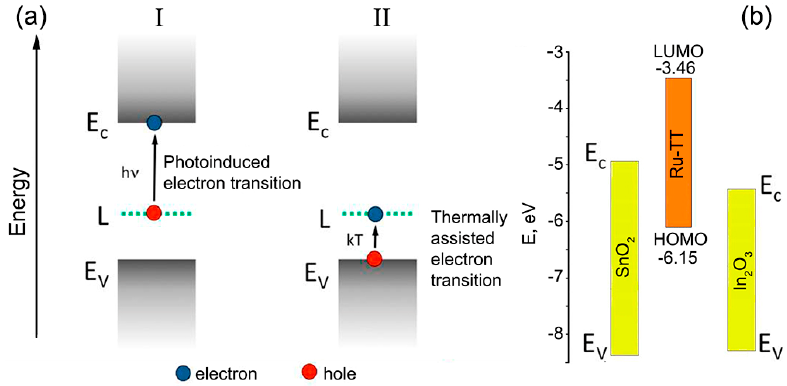
Figure 8. ( a ) Scheme of the consequential mechanism for the generation of holes in pure nanocrystalline oxides under visible light illumination. E v —valence band, E c —conduction band, L —acceptor level. ( b ) Scheme of the mutual arrangement of the energy levels for bulk In 2 O 3 , SnO 2 , and HOMO and LUMO of the Ru-TT complex.